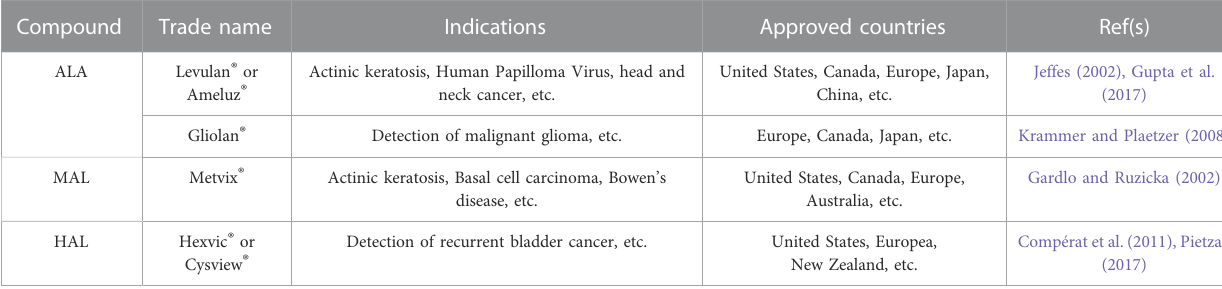
TABLE 1 Clinically used ALA and its derivatives in